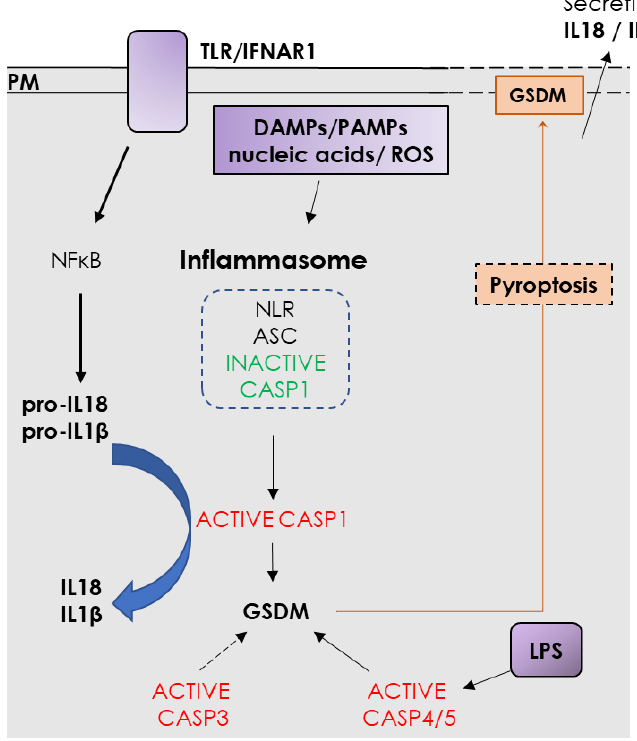
Figure 2. Inflammasome activation and pyroptosis. PM: plasma membrane, TLR: Toll-like receptor, IFNAR1: Interferon associated-receptor 1, DAMP: damage-associated molecular patterns, PAMPs: pathogen-associated molecular patterns, ROS: reactive oxygen species, NLR: NOD-like receptor, IL: interleukin, LPS: lipopolysaccharide.